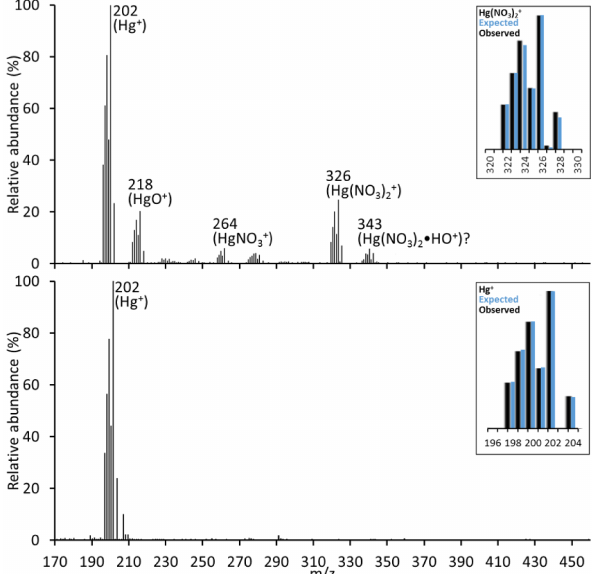
Figure 6. Mass spectrum for Hg(NO 3 ) 2 (above) and HgO (below) derived from direct probe injection into the MS. The boxes at top left in each pane compare the expected indicated mass spectrum (from de Laeter et al., 2004) to the observed spectrum.